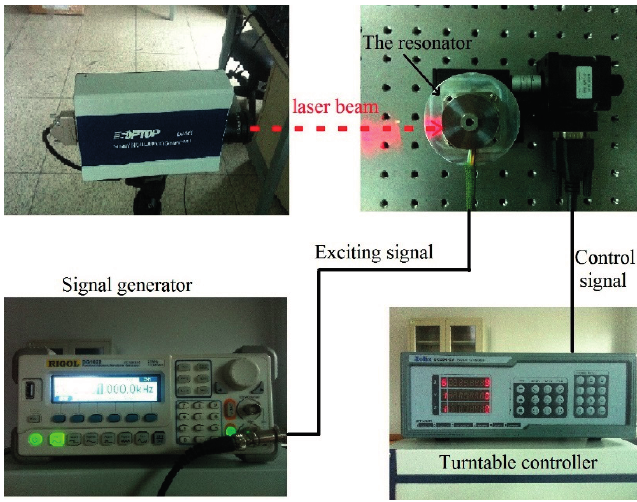
Figure 15. The instruments’ connection flow chart for amplitude curve measurement.